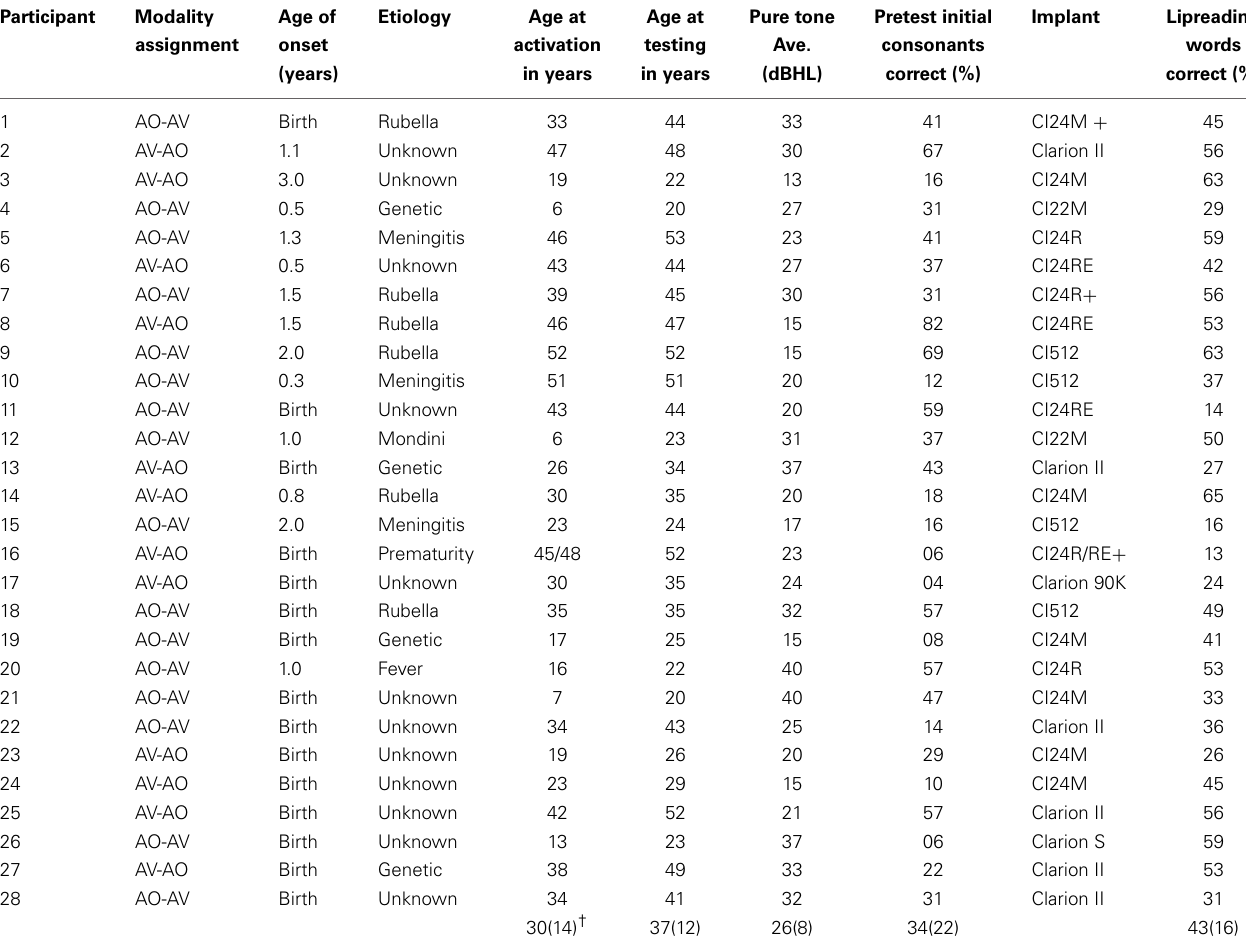
Table 1 | Experiment 1 participants.